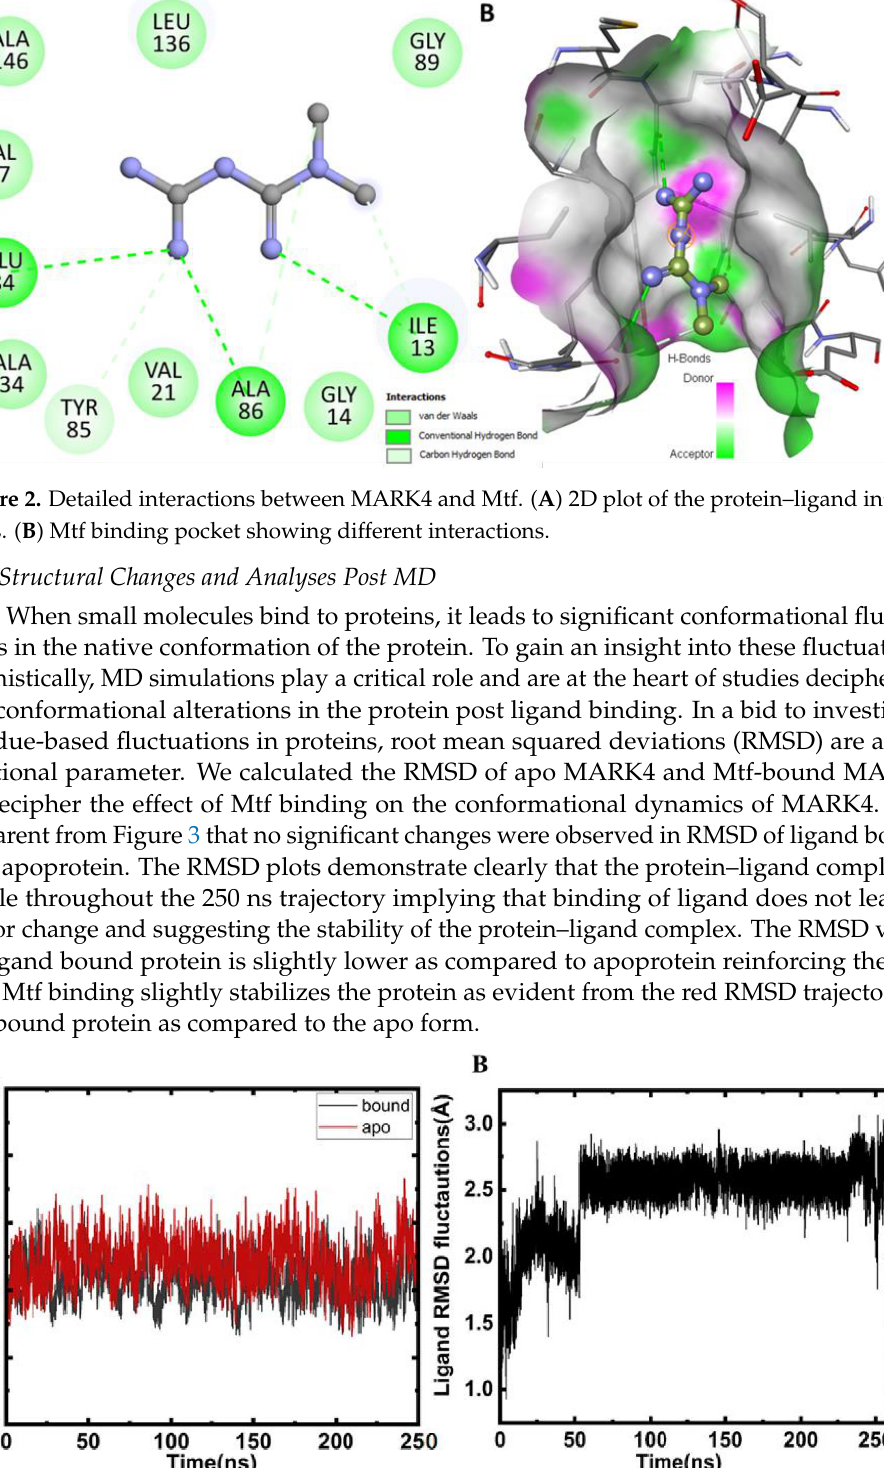
Figure 3. ( A ) RMSD plots of backbone atoms during the 250 ns MD runs. ( B ) RMSD plot of ligand during the 250 ns run.